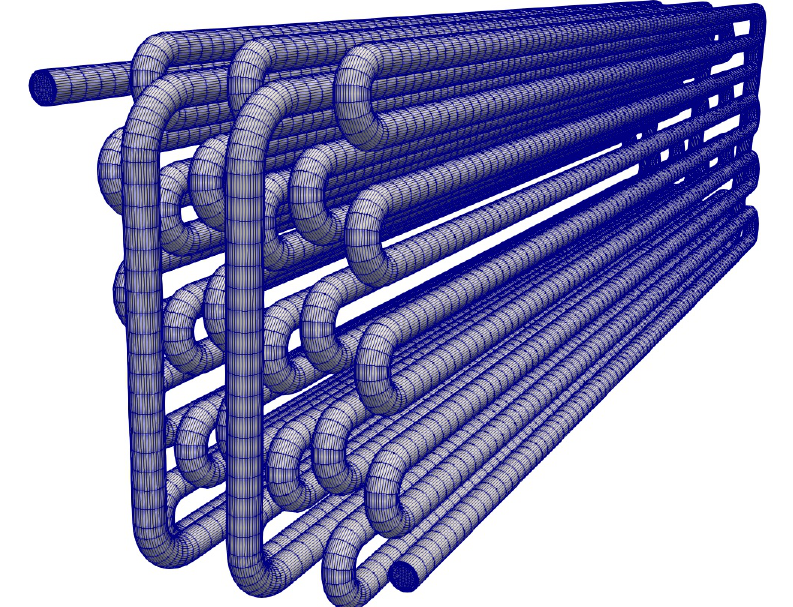
Figure 10. Mesh grid for the convection